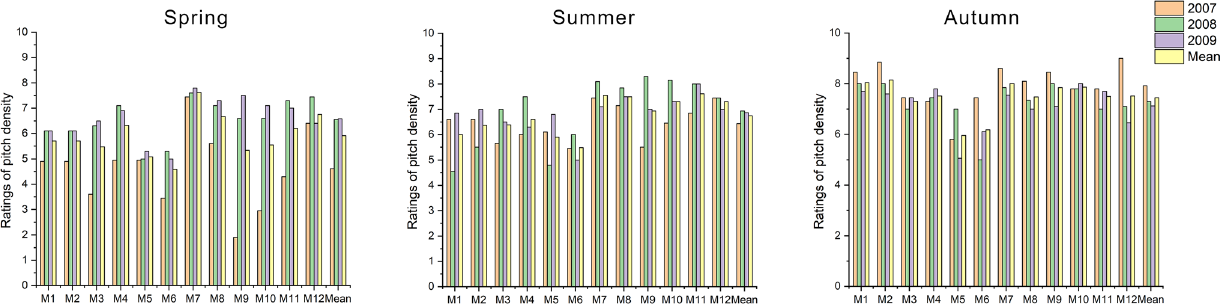
Figure 2. Ratings of pitch density across grass mixtures and research years.